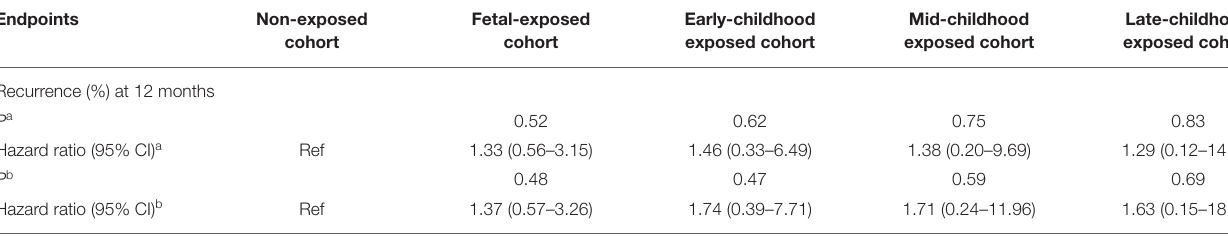
TABLE 2 | Recurrence within 12-month of exposed cohorts compared to non-exposed cohort.